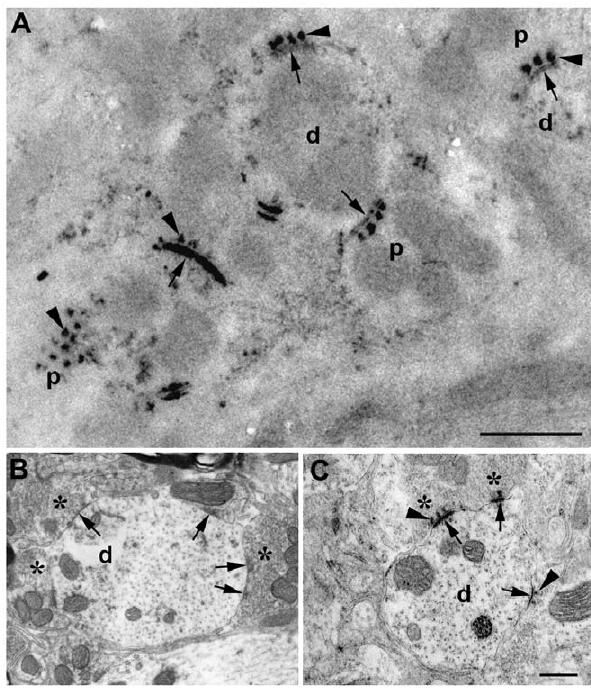
Figure 3. EPTA stained SCZs in AVCN of the normal adult rat. (A) Stained profiles appear dark against an otherwise unstained or grainy background and show, when cut perpendicularly, a characteristic morphology, including dense staining of the postsynaptic specializa- tion, some of which marked by an arrow from the postsynaptic side, and, on the presynaptic side (p), ‘peaks’, ‘projections’, or ‘protrusions’ (arrowheads). When tangentially cut (lower left), these projections appear as a grid of patches. d = dendritic profile, scale bar =1 m m. (B) Section stained with OsO 4 only, showing ultrastructural features such as synaptic vesicles (asterisks) and SCZs (arrows). (C) Section treated as in (B) but with an additional incubation with EPTA revealing presynaptic protrusions (arrowheads), representative of similar frames all failing to show SCZs stained by osmium only. Scale bar for B and C=0.5 m